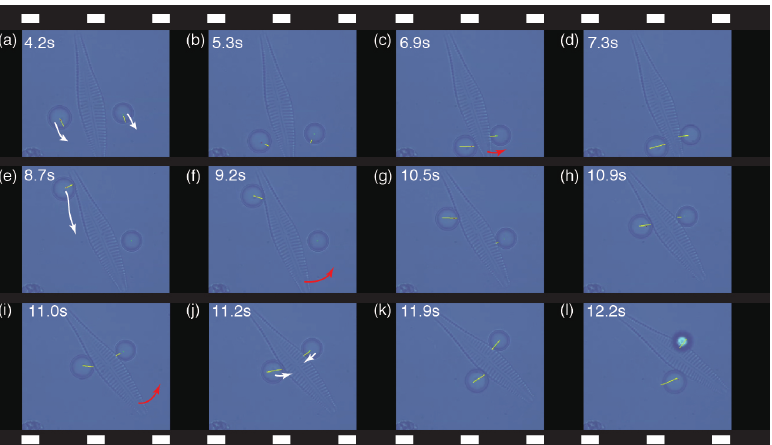
Figure 5. Video frame sequence of the cooperative indirect micromanipulation of a large diatom, with the exerted forces and their directions on the end-effectors (7.8 µ m microbeads) displayed by yellow lines in real time. In each snapshot, the movement direction of the microbeads and the diatom during cooperative manipulation are indicated by white and red arrows, respectively. The images are also shown in Supplementary Video